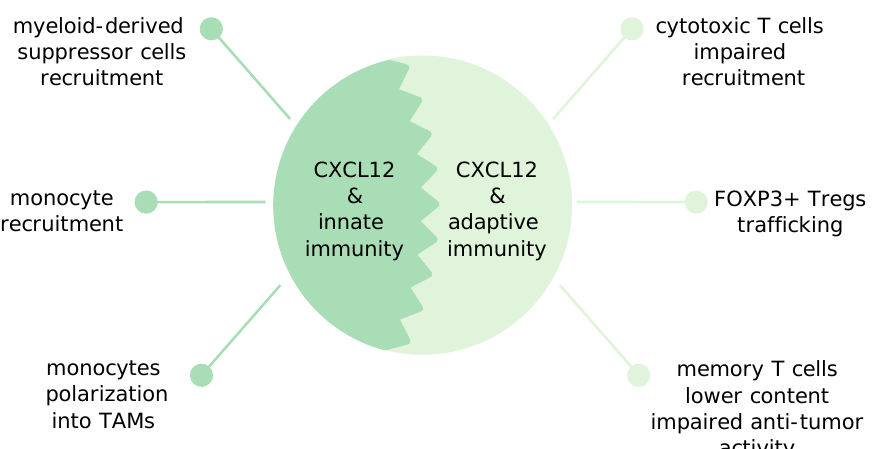
Figure 1. CXCL12 a ff ects both innate and adaptive immunity in cancer. On the one hand, the e ff ects on innate immunity include the recruitment of myeloid-derived suppressor cells, monocyte recruitment and their polarization into tumor-associated macrophages (TAMs). On the other hand, the e ff ects on adaptive immunity are mostly T cells related. CXCL12 attenuates cytotoxic and memory T cells recruitment and increases the content of immunosuppressive FOXP3 + T regulatory cells